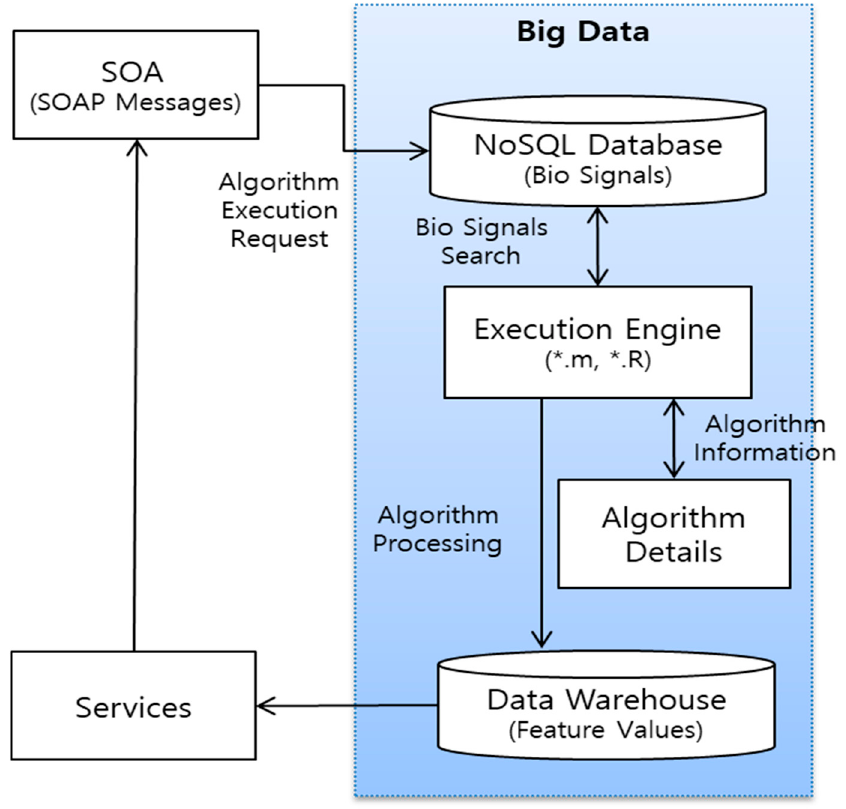
Figure 4. SOA-based bio-signal analysis system architecture.